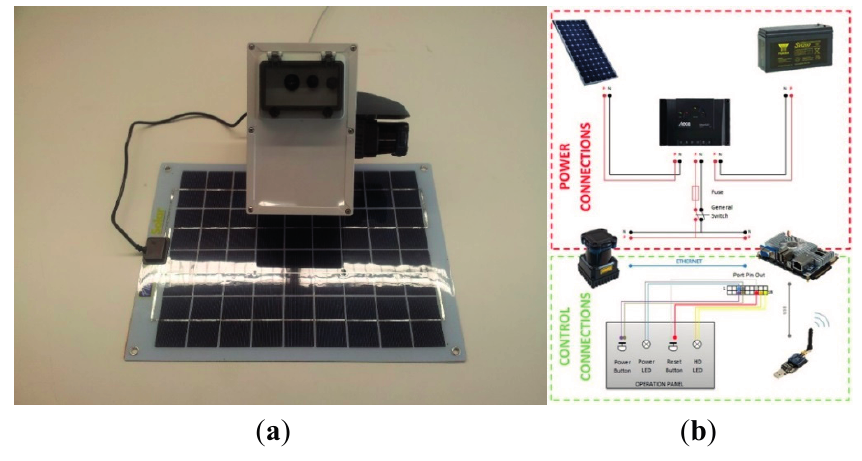
Figure 6. UIS Laser node. ( a ) UIS Laser node; ( b ) UIS Laser node hardware.